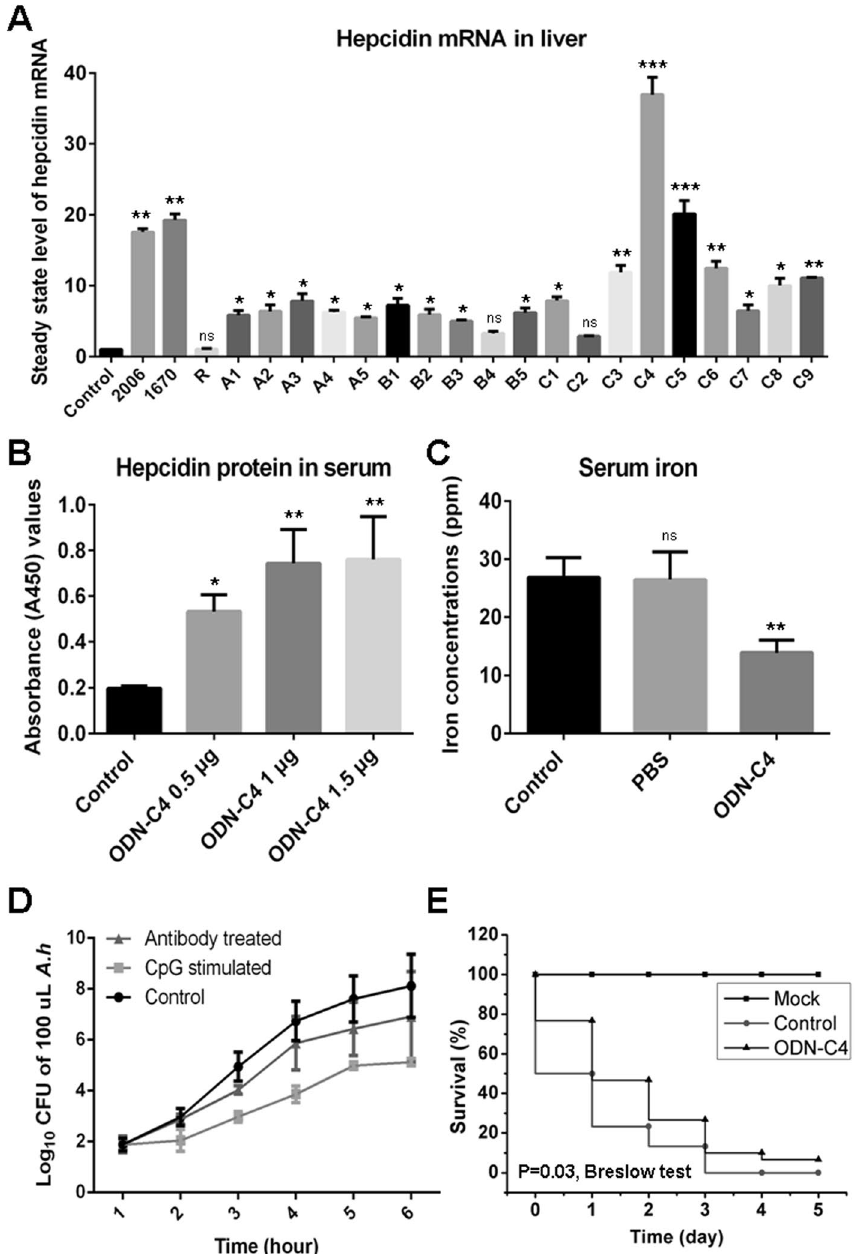
Figure 6. Screen of CpG-ODNs for hepcidin induction and its immunoprotection to bacterial infection. ( A ) The steady state level of hepcidin mRNA in liver upon various CpG-ODNs stimulation as determined by Q-PCR. The control fish (indicated as Control) received mock PBS. The sequences of the three known CpG- ODNs (2006, 1670 and R) and the candidate CpG-ODNs with Class A (A1–A5), Class B (B1–B5) and Class C (C1–C9) stimulatory motifs was shown in Supplementary Table S1. ( B ) Dose-dependent effect of ODN-C4 on the induction of hepcidin protein in serum as determined by ELISA, A 450 represents absorbance (A 450 ) value. The control fish (indicated as Control) received mock PBS. ( C ) Detection of iron concentration in serum of fish receiving ODN-C4 stimulation as determined by ICP-MS. Serum sample derived from the zebrafish without any treatment was the control group (indicated as Control), and serum sample derived from the mock PBS- injected zebrafish was the PBS group (indicated as PBS). ( D ) Examination of A. hydrophila ( A.h ) growth in M9 medium cultured in the presence of unstimulated serum (indicated as Control), 1.5 μ g ODN-C4 stimulated serum (indicated as CpG stimulated) and stimulated serum neutralized with diluted (1:1,000) anti-hepcidin Ab (indicated as Antibody treated). ( E ) Survival rate of ODN-C4 stimulated fish within 5 days after A . hydrophila infection. The mock group received only ODN-C4 without bacterial challenge (indicated as Mock) and the control group received sterile PBS 24 h before the bacterial challenge (indicated as Control). All data are representative of at least three independent experiments. A significant difference was detected between each experimental and control group. * p < 0.05, ** p < 0.01, *** p < 0.001. ns for not